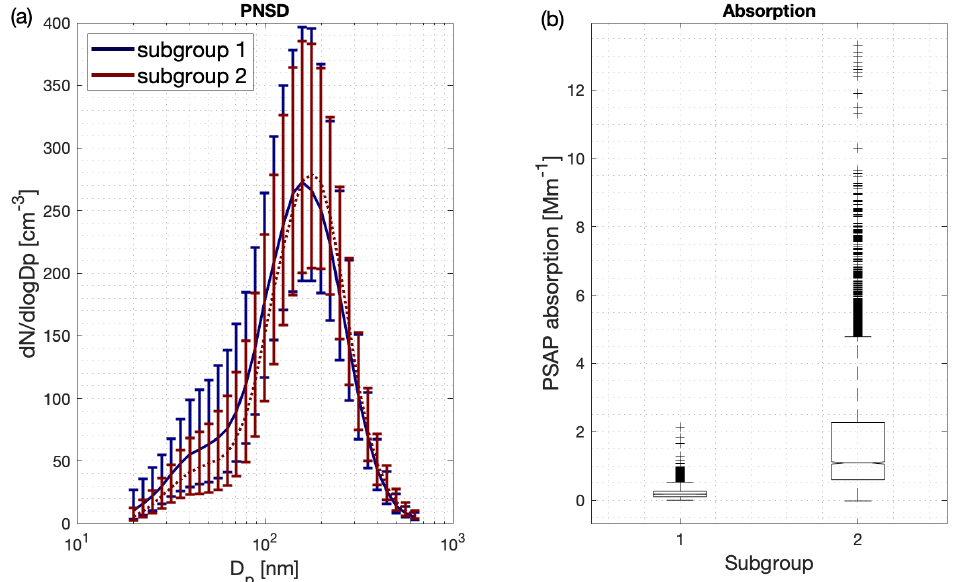
Figure A1. ( a ) shows the particle number size distribution in [cm − 3 ] for the two subgroups, Subgroup 1 in blue and Subgroup 2 in red. ( b ) Absorption in [Mm − 1 ] as measured by the PSAP at the station for all valid data points for the two